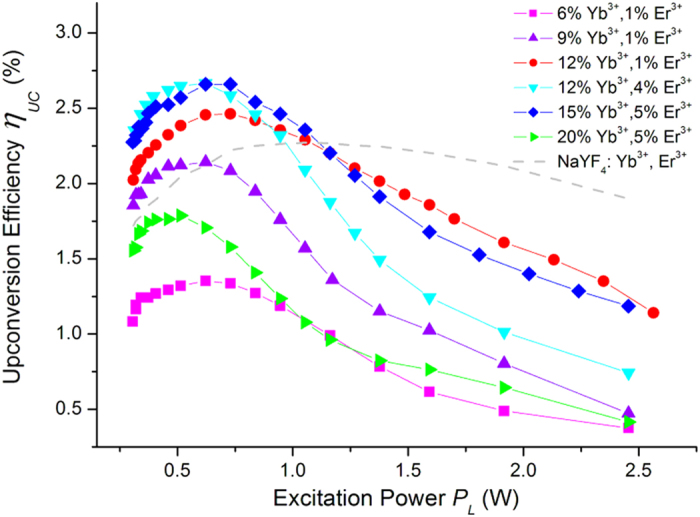
UC power efficiency test.UC power efficiency of several Ba5Gd8Zn4O21:Yb3+, Er3+ phosphors under different excitation power, the UC power efficiency of commercial NaYF4:Yb3+, Er3+ phosphor is also provided as a contrast.